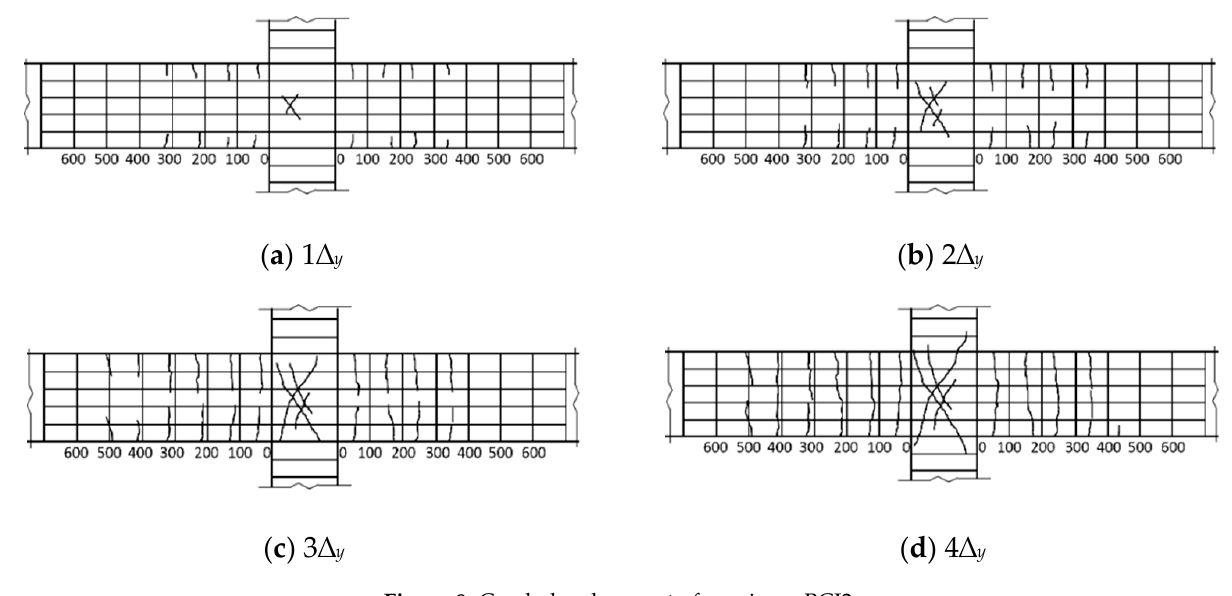
Figure 8. Crack development of specimen BCJ2.